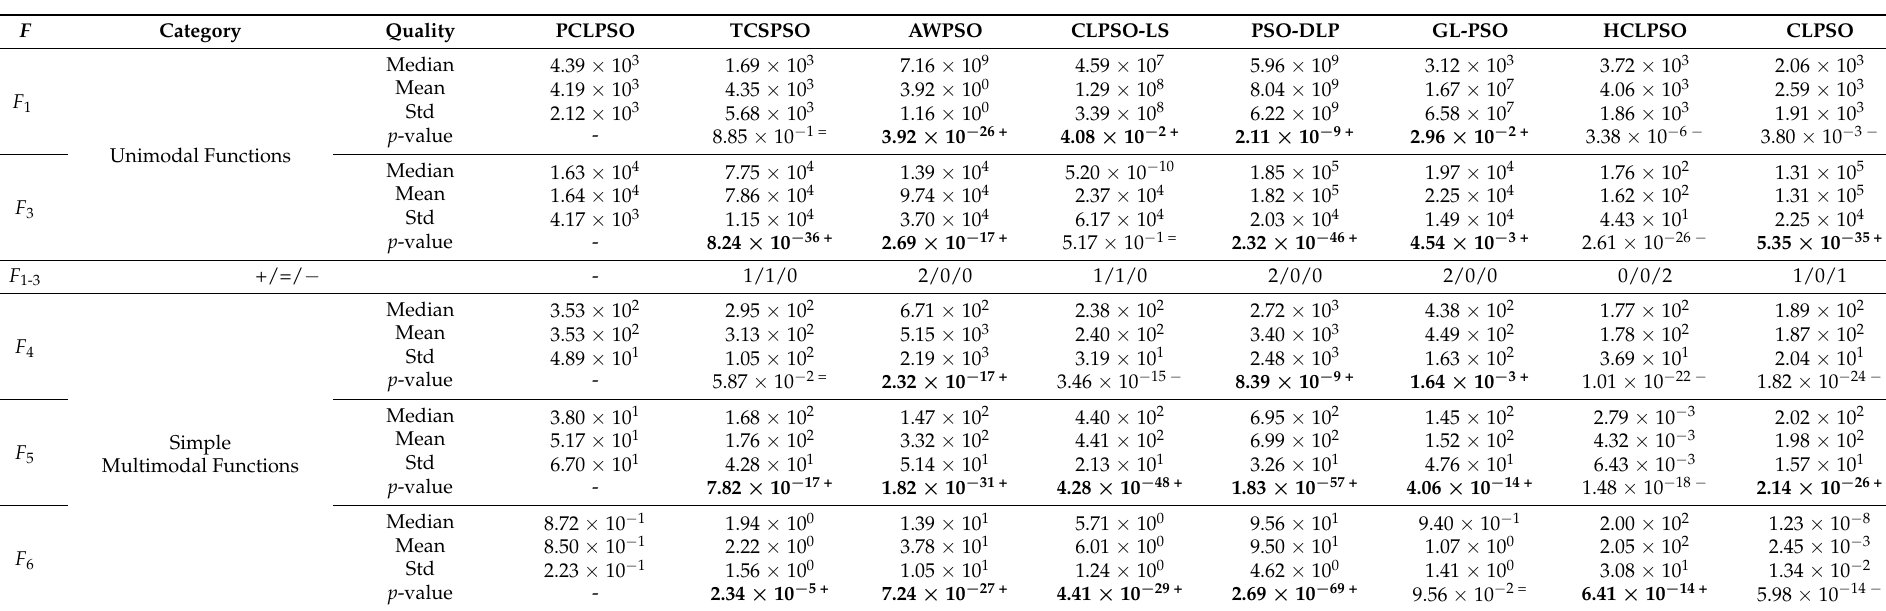
Table 4. Global fitness comparisons between PCLPSO and the seven selected PSO methods on the CEC 2017 benchmark set with the dimensionality set as